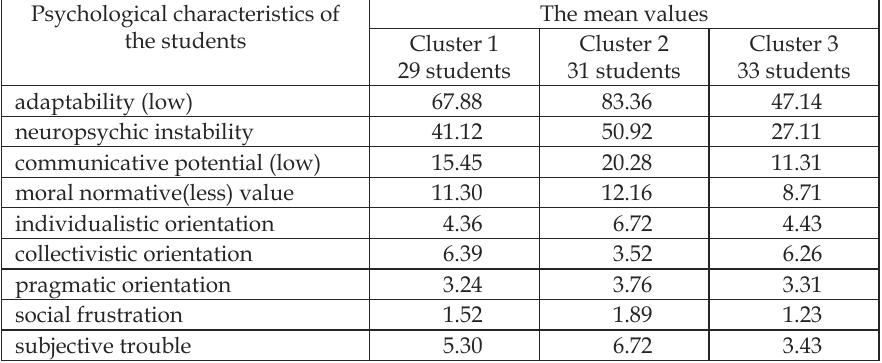
Tab. 1. The mean values of indices of psychological characteristics in three